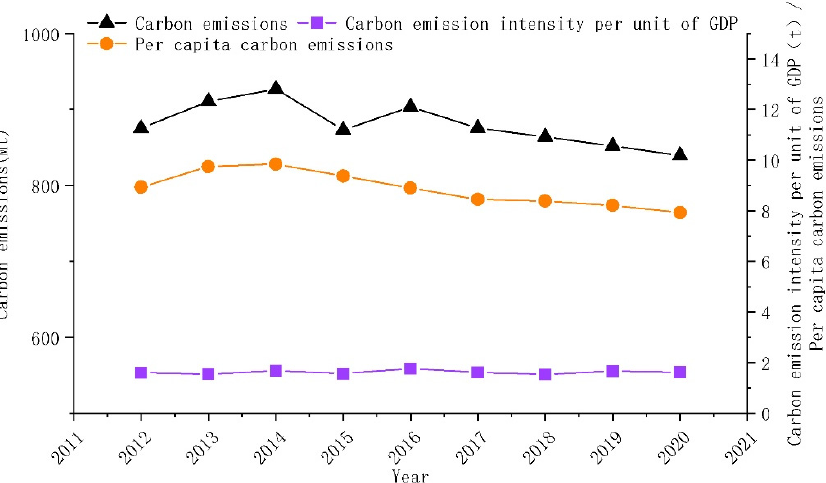
Figure 4. Changes in overall carbon emissions, per capita carbon emissions, and carbon intensity in